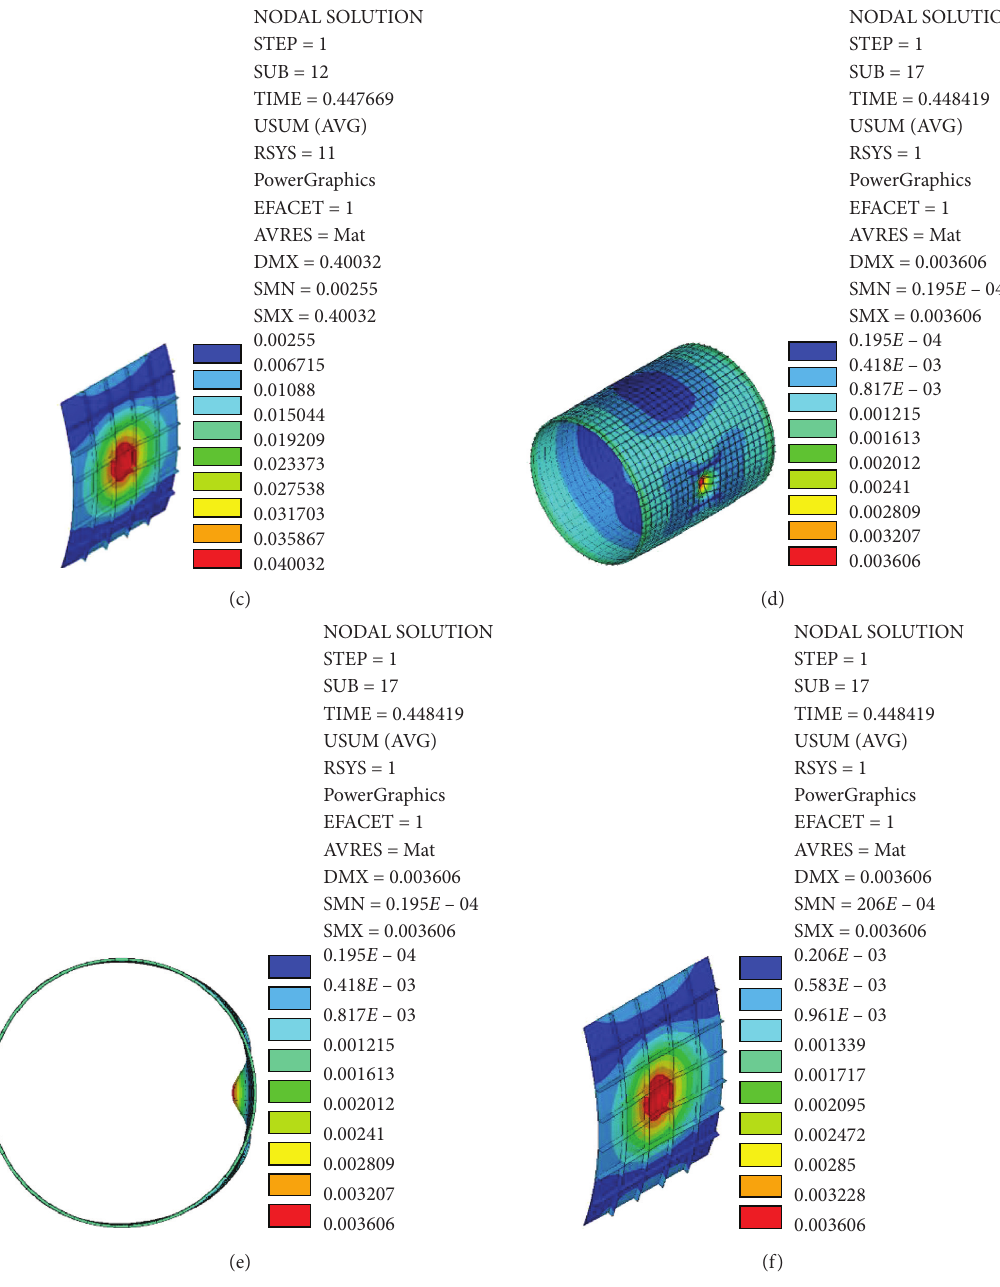
Figure 5: Comparison of buckling modes between the prototype and complete similitude model when λ δ 0 � 0.5 t . (a) Oblique view of the prototype (10x magnification). (b) Front view of the prototype (10x magnification). (c) Near imperfection of the prototype (1x). (d) Oblique view of the model (10x magnification). (e) Front view of the model (10x magnification). (f) Near imperfection of the model (1x). Table 6: Material parameters of the scale